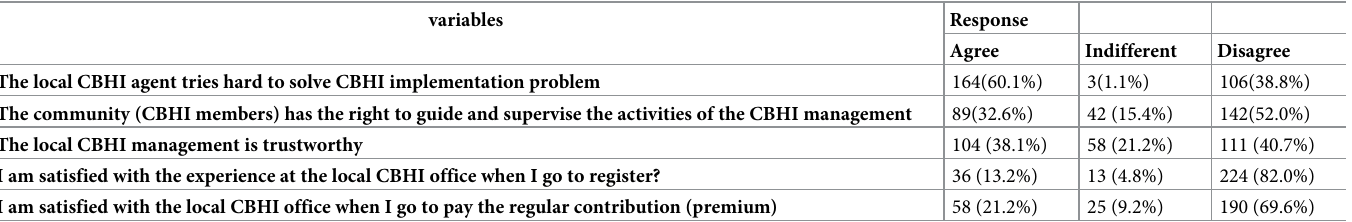
Table 3. Community based health insurance experience of the enrolled households in Segen area and South Omo Zones, 27 April to 12 June 2018 (n =